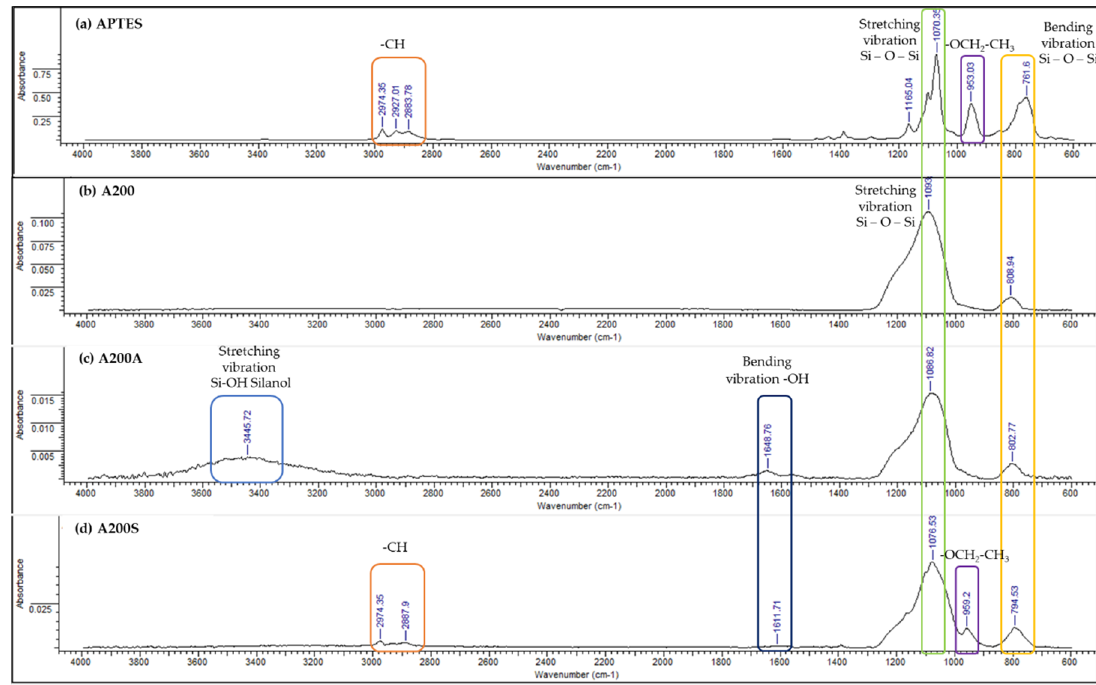
Figure 8. Infrared Spectrum of ( a ) APTES, ( b ) A200, ( c ) A200A and ( d )A200S NPs.